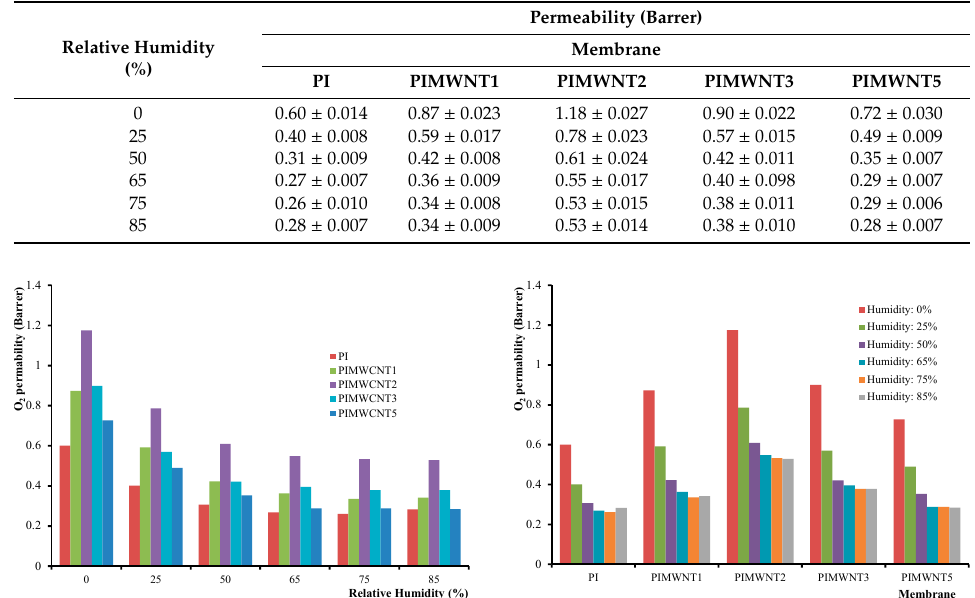
Table 4. O 2 permeability values at di ff erent humidity levels.